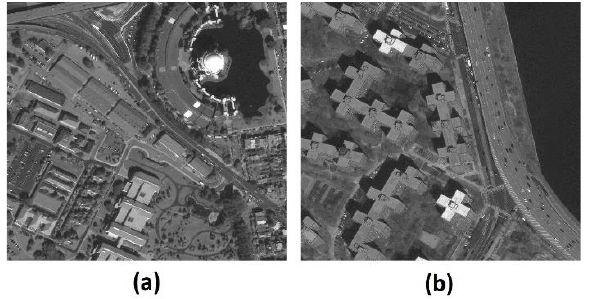
Figure 5. The first principal components (PC1): (a) San Francisco dataset, (b) NY dataset